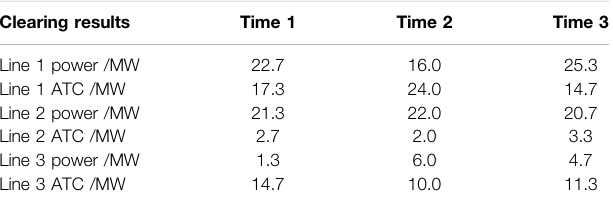
TABLE 4 | Capacity constraints of inter-provincial electricity power transmission